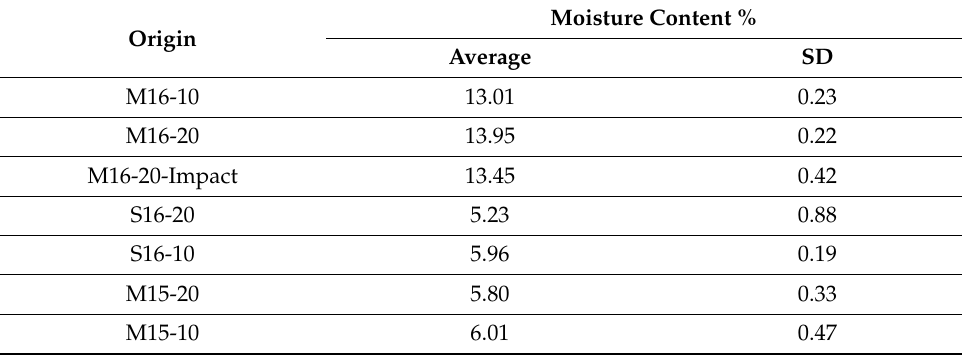
Table 6. Moisture content of different rapeseed straws.